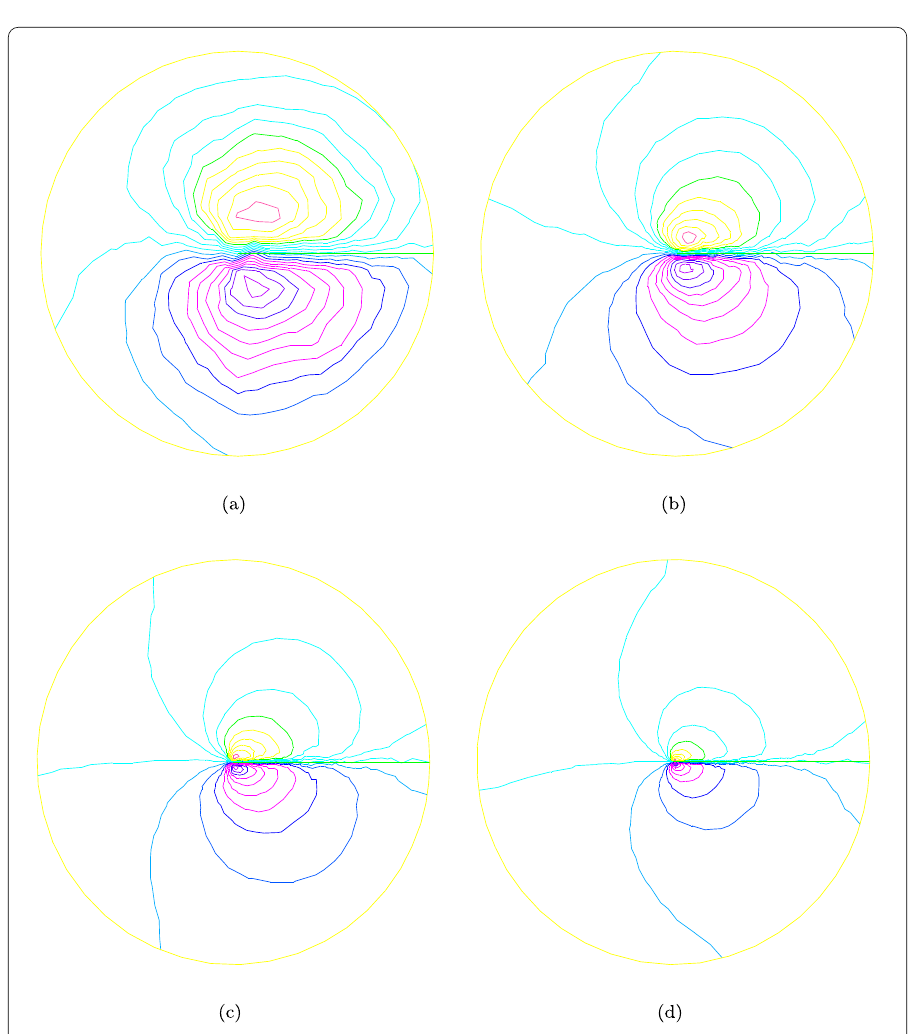
Figure 4 The contours of pressure. ( a ) Initial mesh. ( b ) Mesh after step 1. ( c ) Mesh after step 2. ( d ) Mesh after step